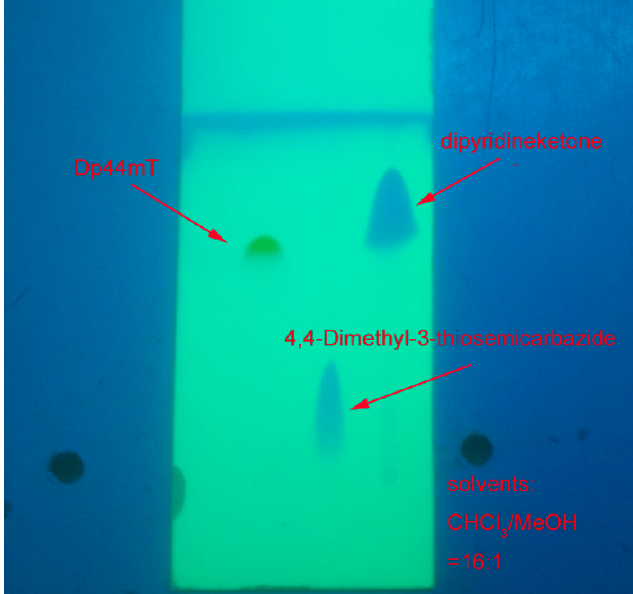
Figure C1. Thin layer chromatography (TLC) of synthesized Dp44mT.